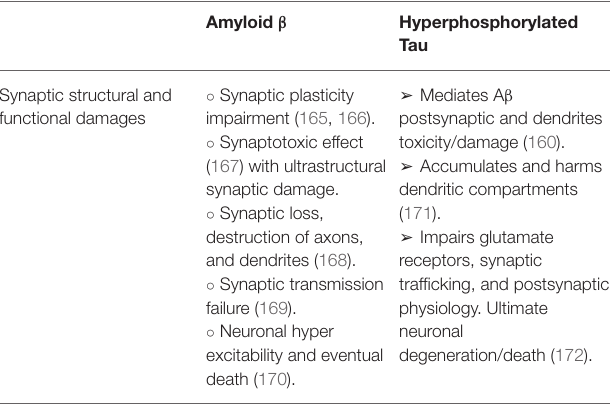
TABLE 1 | Summarized synaptic damages associated with A β toxicity and hyperphosphorylated Tau. Amyloid β Hyperphosphorylated